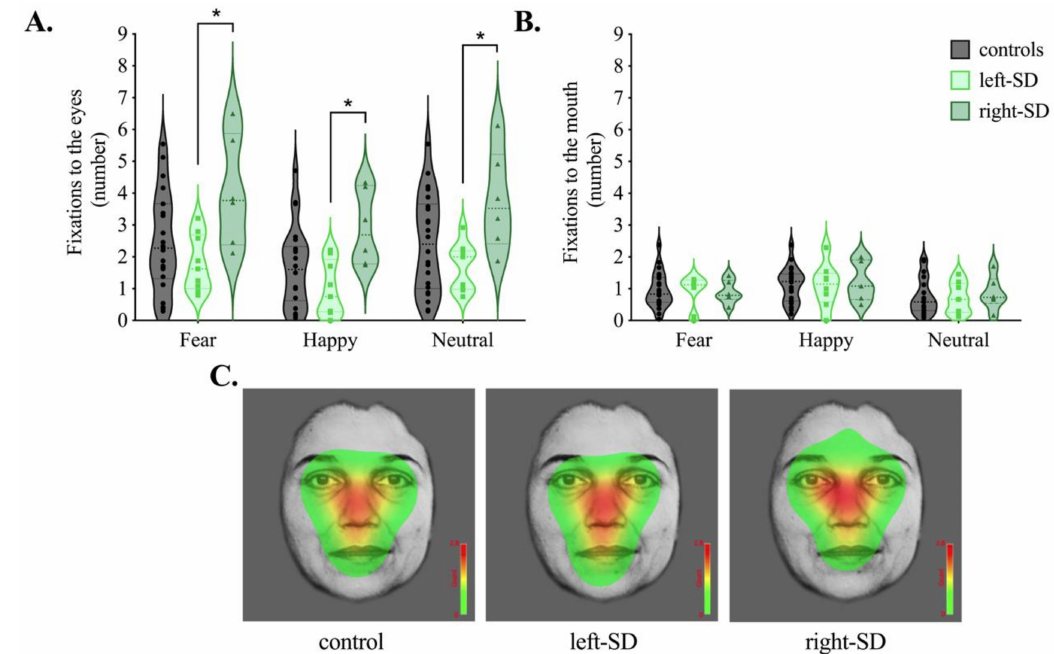
Figure 3. Average number of fixations to the ( A ) eyes and ( B ) mouth in controls (grey), left-lateralised semantic dementia (left-SD, light green) and right-lateralised semantic dementia (right-SD, dark green) for fear, happy and neutral conditions. ( C ) Heat maps corresponding to the maximum per-trial average for the number of fixations across conditions (fear, happy, neutral) in each group. Colours on the heat map represent how often participants looked at the faces on average, with red representing areas where the most fixations occurred. * p <